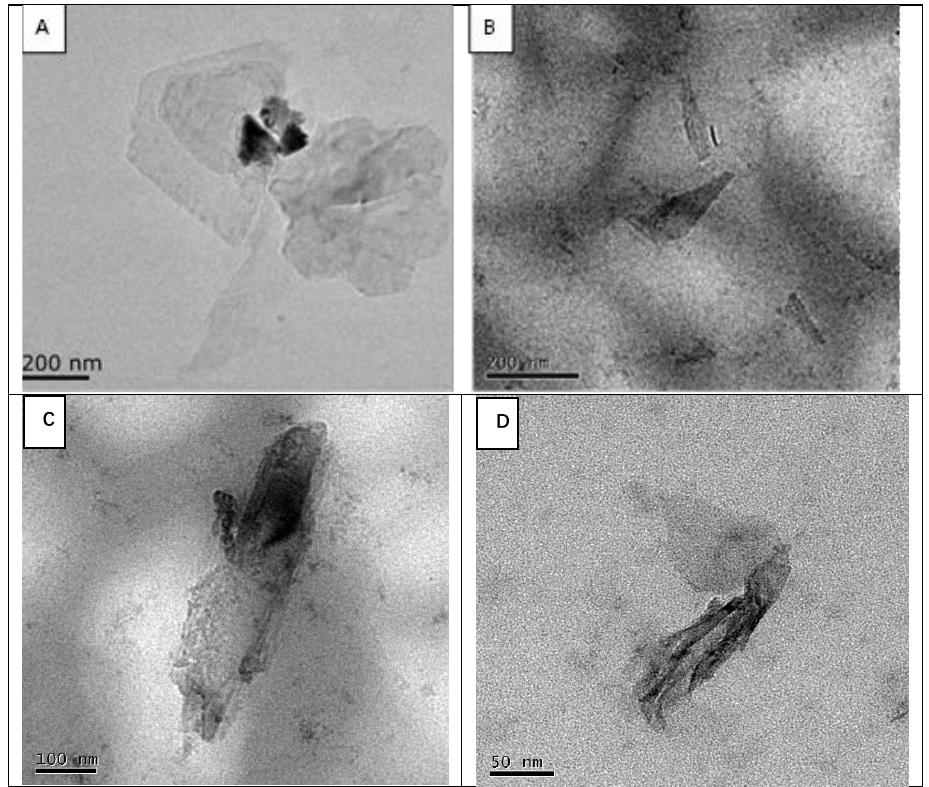
Figure 1. TEM of ( A ) BPNSs and ( B – D ) PLL − BPNSs. The dark-colored background of ( B – D ) is polylysine.